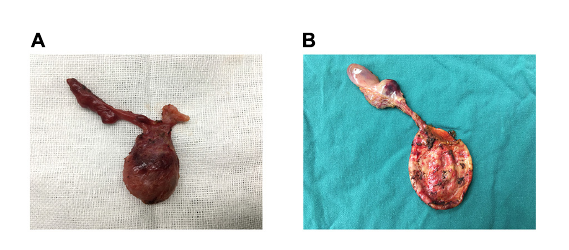
FIGURE2 (A) CBA: gallbladder dysplasia, a fibrous mass, and the largest cyst of all CBA cases (3 cm). (B) CC: a normal gallbladder, no hilar fibrous mass, and a large